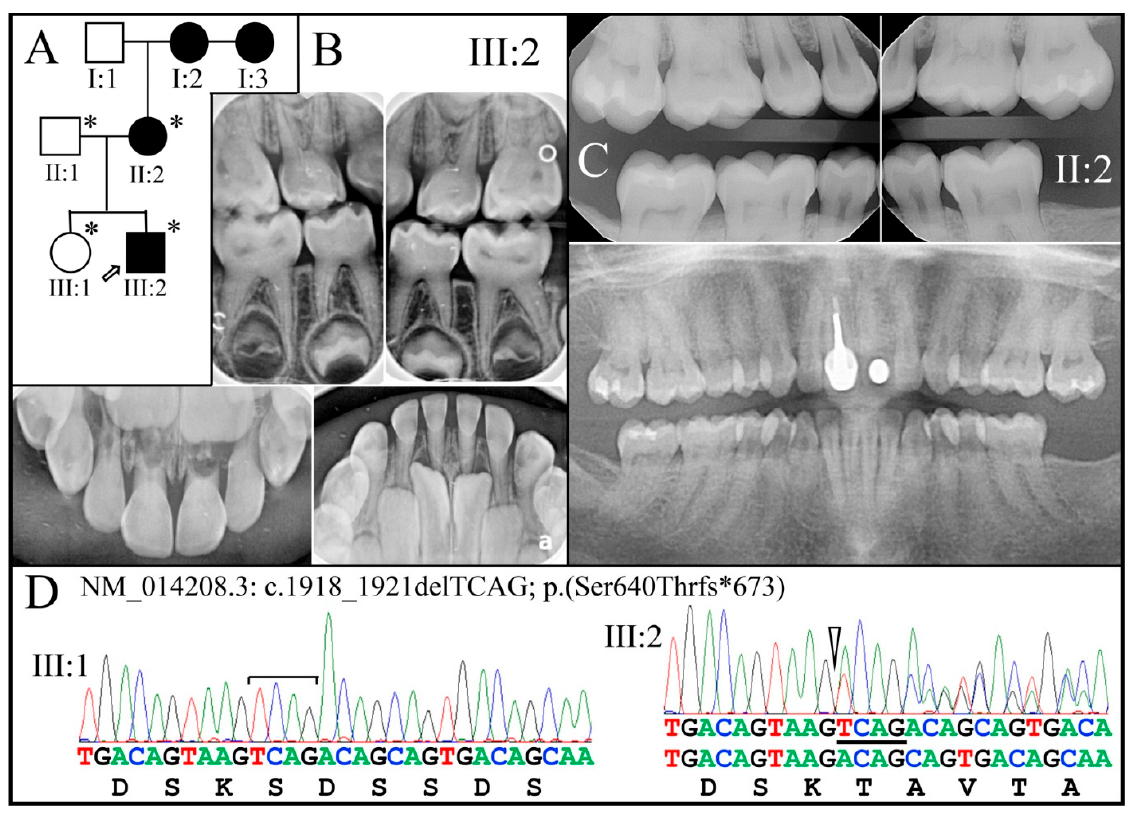
Figure 9. Family 6. ( A ): Three-generation pedigree of a family diagnosed with dentin dysplasia type II following an autosomal dominant pattern of inheritance. ( B ): The radiographs of the proband taken at age 5-years 6-months showed premature obliteration of the root canals and bulbous molar crowns in primary dentition. ( C ): The permanent dentition of the proband ′ s mother (II:2) appears to be mildly affected, presenting the characteristic “thistle-tube” shaped pulp chambers characteristic of DD-II. ( D ): The dental phenotype was caused by deletion of 4 nucleotides (TCAG) from a single DSPP allele (NM_014208.3: c.1918_1921delTCAG; p.Ser640Thrfs*673). Key : * denotes enrolled participants.